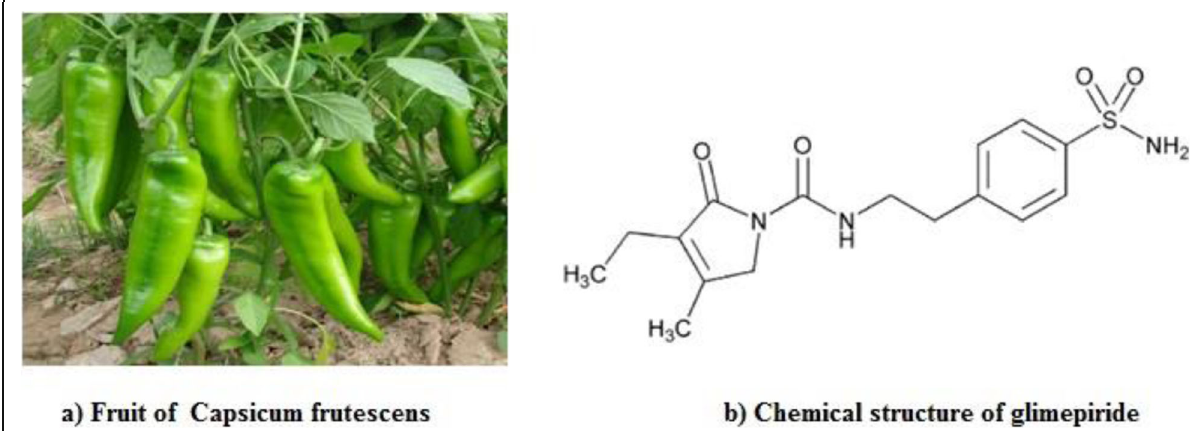
Fig. 1 Image of C.frutescens and chemical structure of